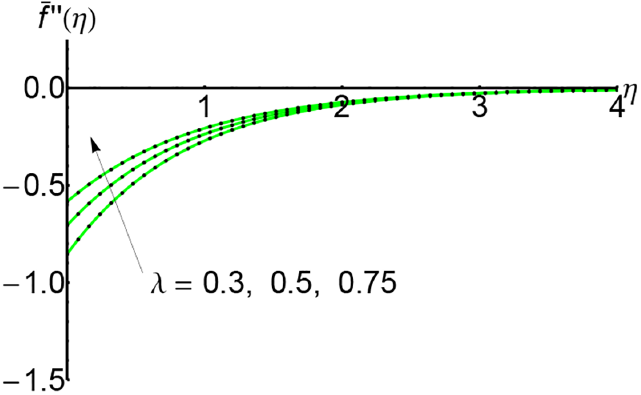
Fig 2. Variation of horizontal velocity (cid:2) f 0 ð Z Þ with η for different values of slip parameter λ and for S = 1: —— numerical solution ......... . OHPM solution.